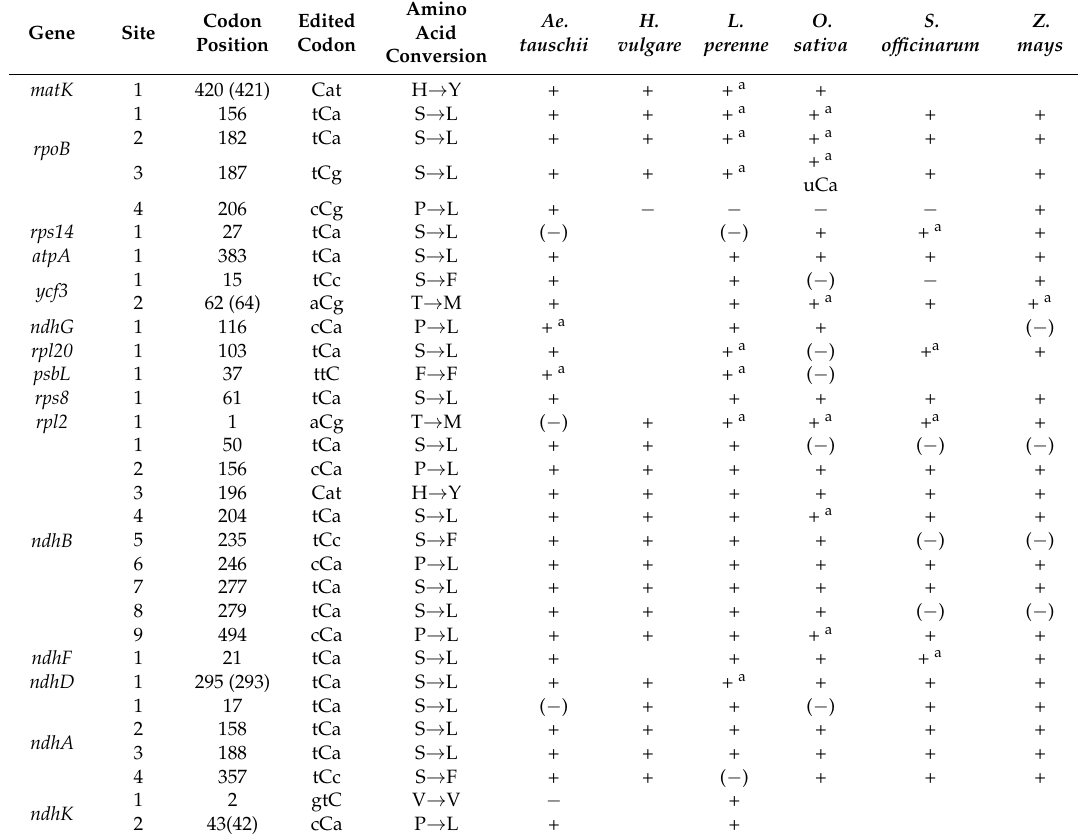
Table 4. Comparative analysis of RNA editing sites in chloroplast genes among six Poaceae species.